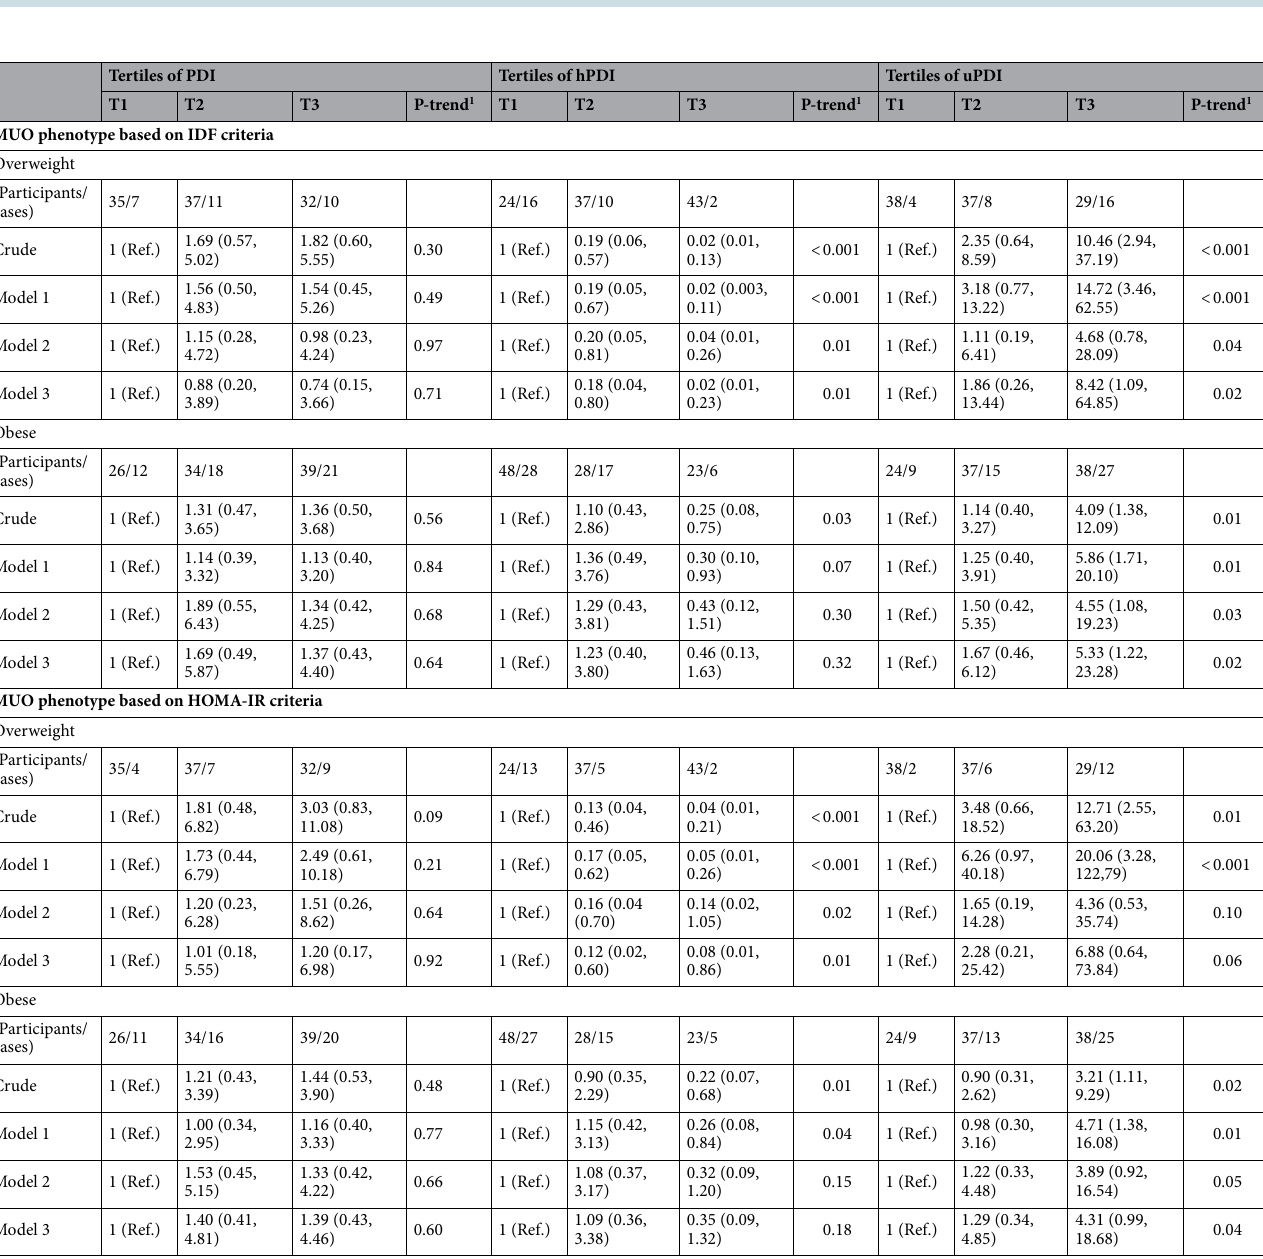
Table 5. Multivariate adjusted odds ratio (OR) and 95% confidence interval (CI) for MUO phenotype across tertiles of PDI, hPDI and uPDI, stratified by BMI categories. All values are odds ratios and 95% confidence intervals. Model 1: Adjusted for age, sex, and energy intake. Model 2: Additionally, adjusted for physical activity and socioeconomic status (evaluated based on parental education level, parental job, family size,